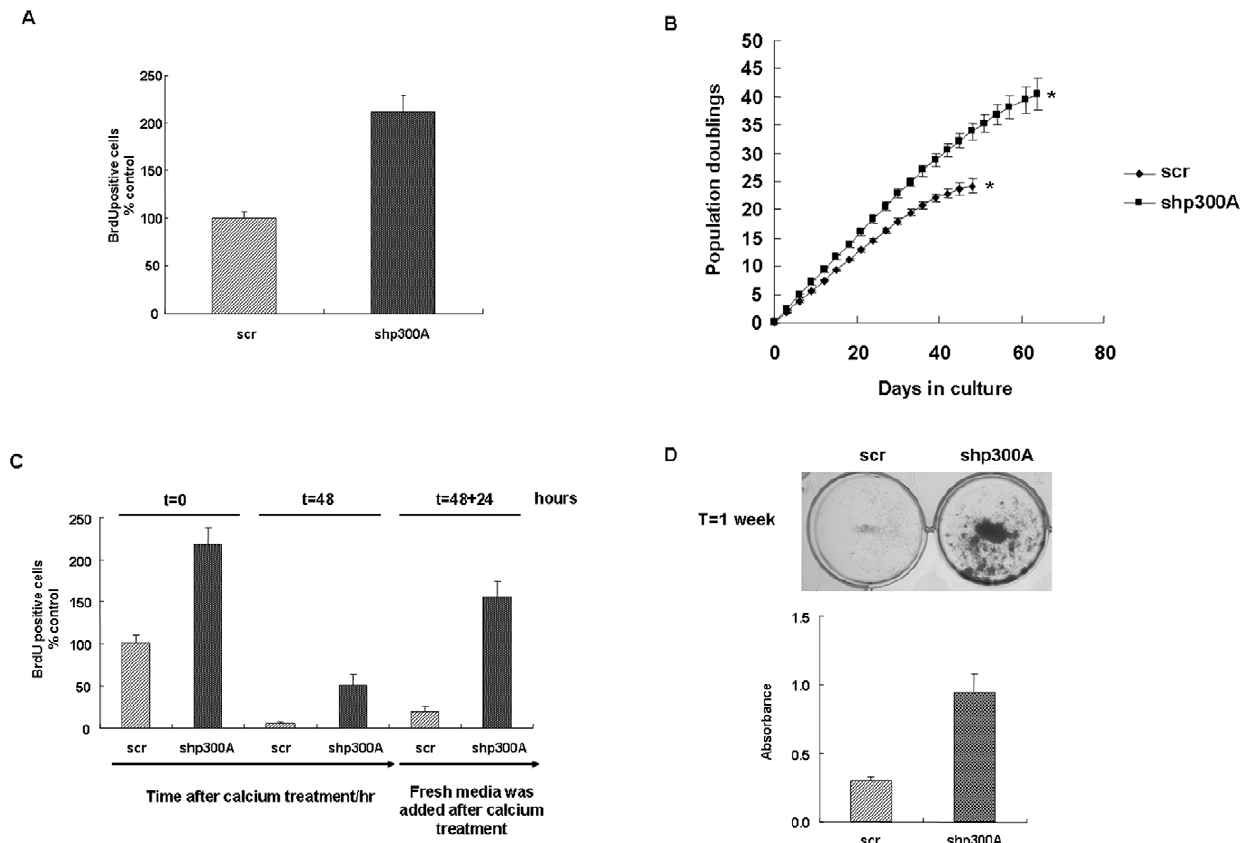
Figure 3. Stable p300 knockdown increases the proliferation of HFKs and allows the differentiating HFKs to re-enter cell cycle. ( A ) Cycling HFKs stably expressing p300 targeted shRNAs in culture were pulsed with BrdU prior to fixation. Graph represents percentage of BrdU positive cells, expressed relative to scrambled control in cycling cells (mean + / 2 SE of four independent experiments). ( B ) Graph shows life span progression of stably transduced cell lines. Asterisk (*) indicates the population doubling (PD) level at which senescence occurred. ( C ) Stably transduced cell lines were seeded onto coverslips and treated with 1.5 mM calcium for 48 hours. After 48 hours, cells were incubated with fresh media for 24 hours (t=48 + 24). ( D ) Differentiated HFKs were replated onto six well plates and cells were stained with crystal violet after incubating with fresh media for 7 days. Histogram represents three independent experiments calculating the average A540 nm reading of crystal violet solutions following destaining of